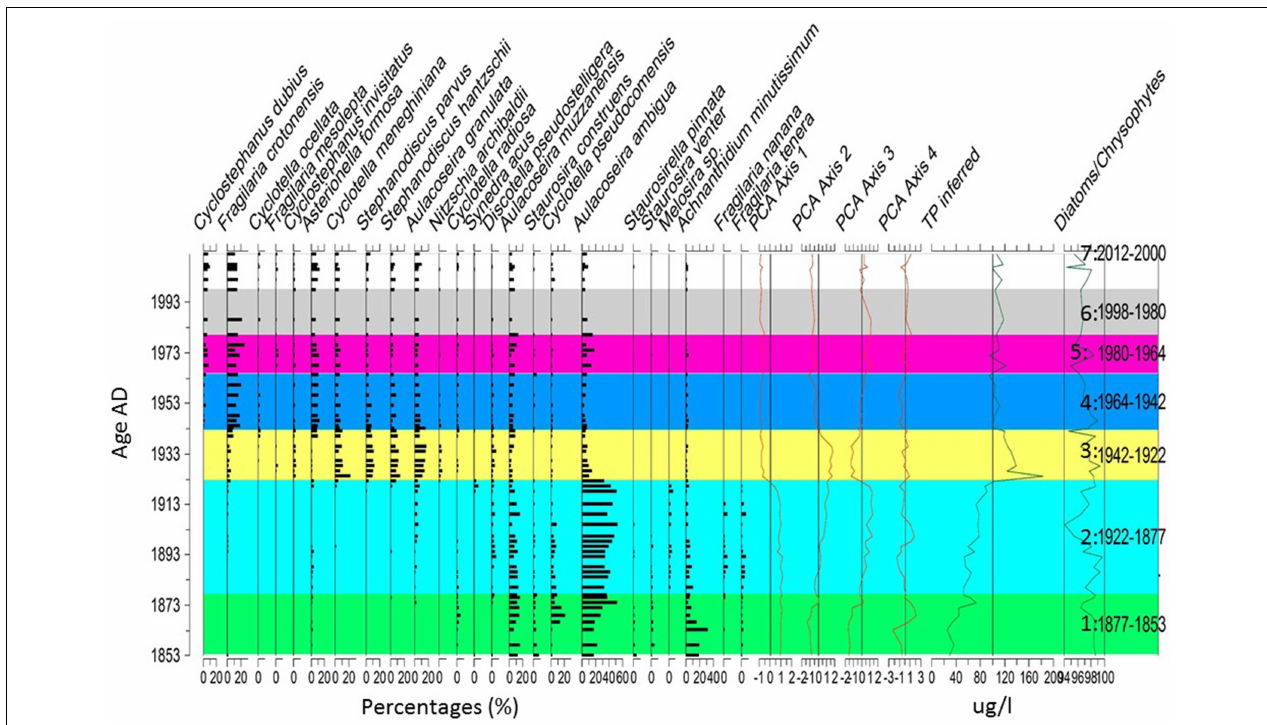
FIGURE 6 | Diatom diagram. The taxa are in percentages. The zones were created using the technique of optimal splitting by information content (Birks and Gordon, 1985 ) and the number of statistically significant zones was identified using the Psimpoll 4.27 software (Bennett, 2009).